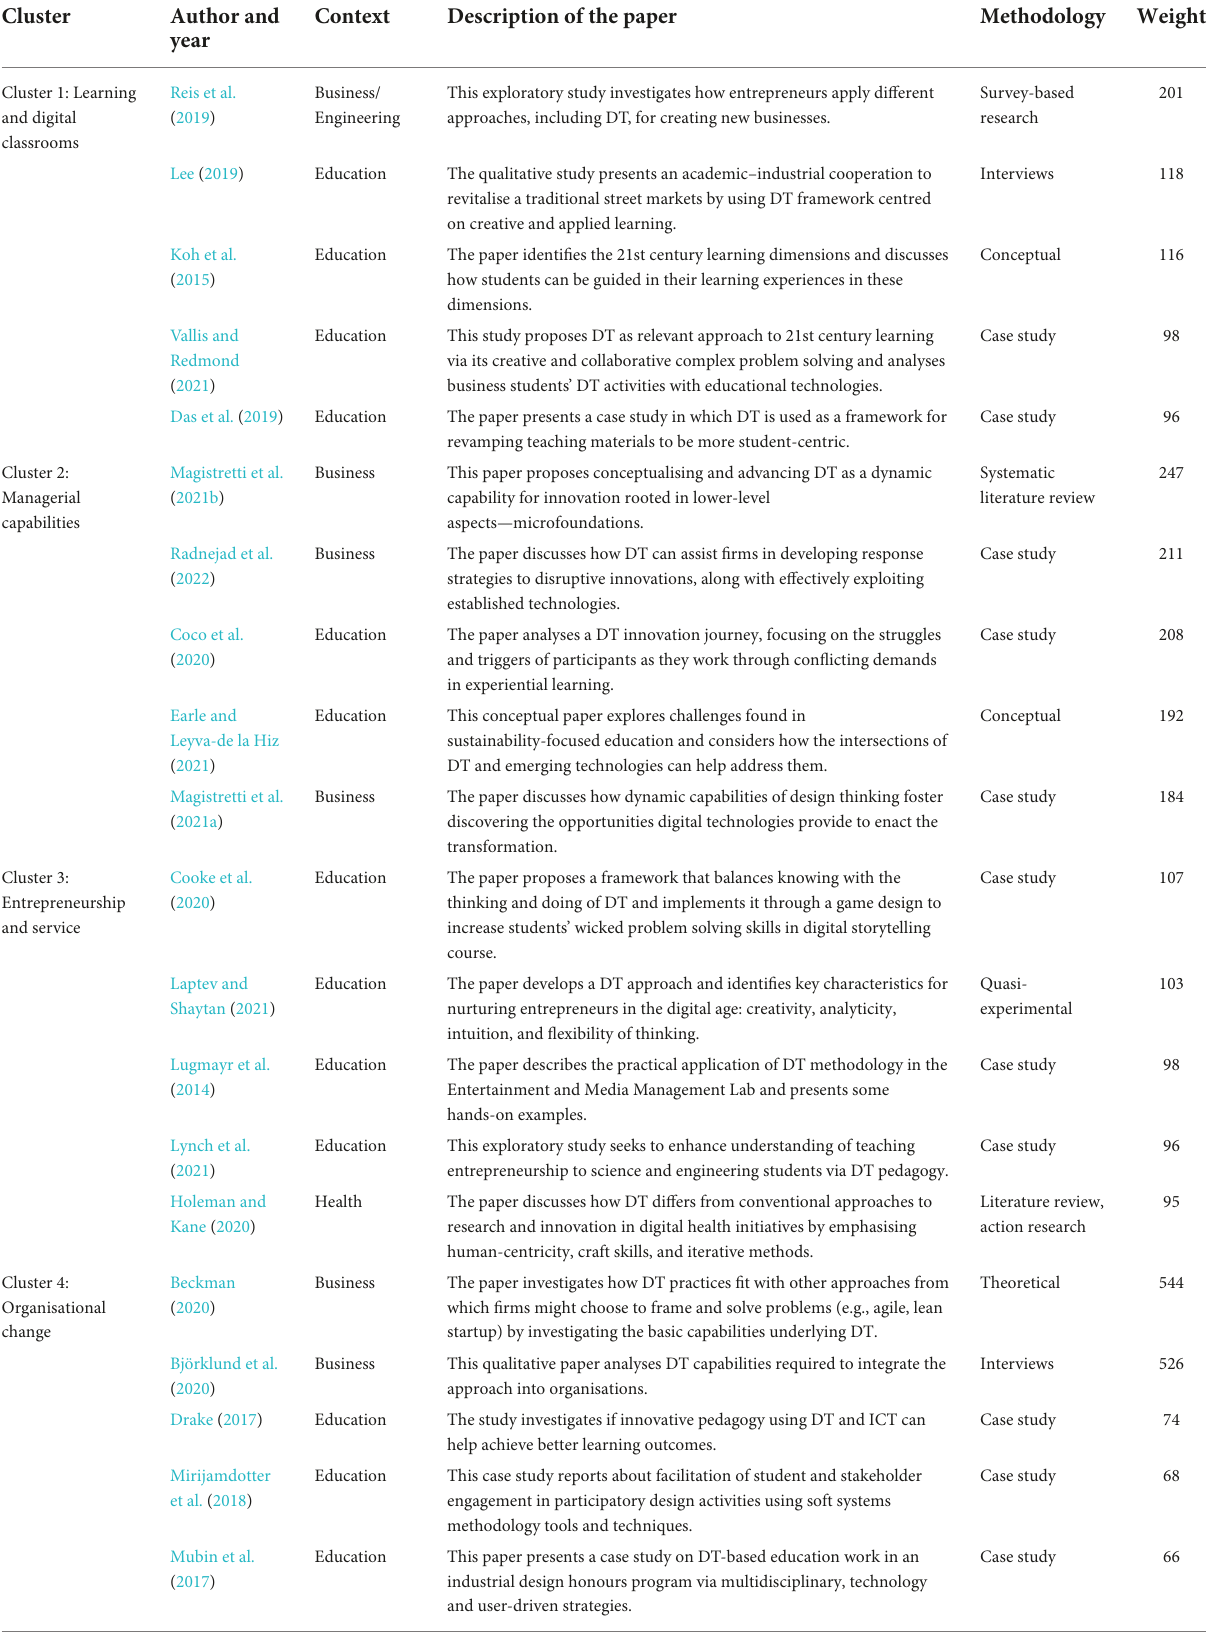
TABLE 2 Top 5 most important papers for each cluster in the bibliographic coupling